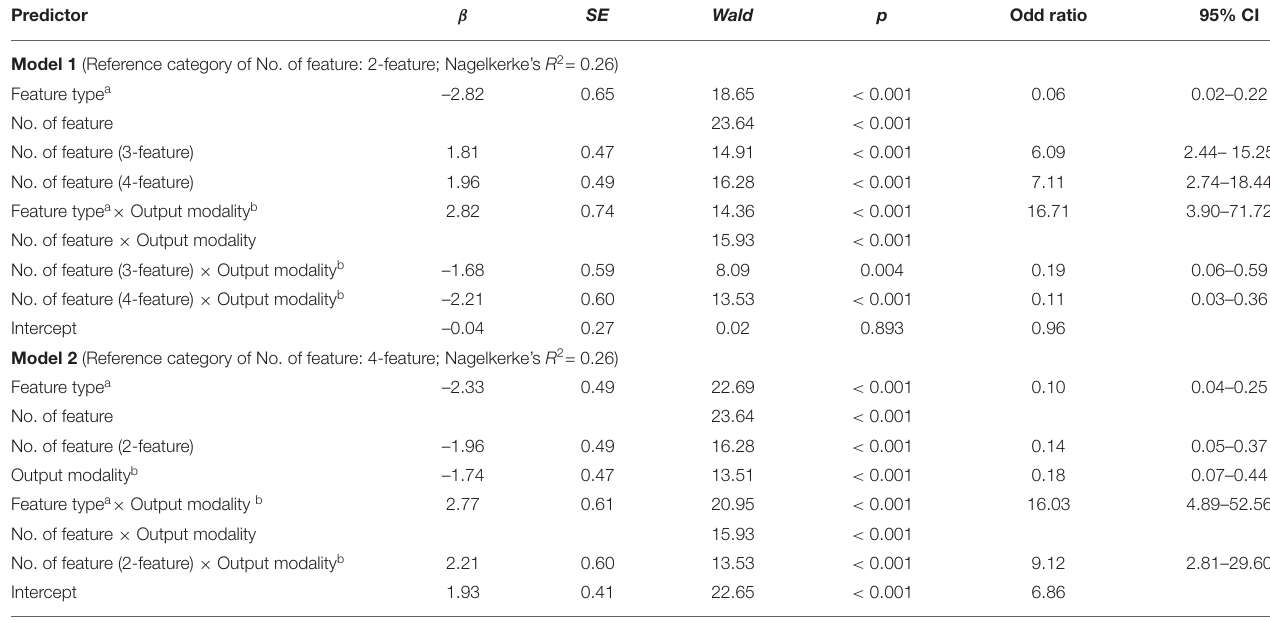
TABLE 7 | (Formal study) Significant effects of output modality, feature type, the number of features, and their interaction terms on User Interest in the Recommendation (“Interested in” =1, “Not interested in” = 0) by logistic regression. Predictor β SE Wald p Odd ratio